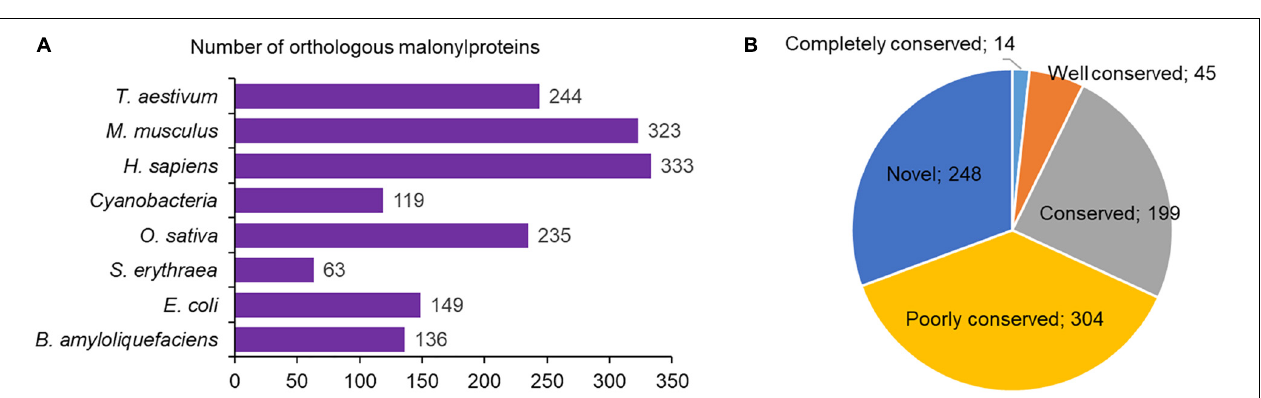
PsbC, PsbB, PsbO, PsbP, PsbQ, and PsbS were identified